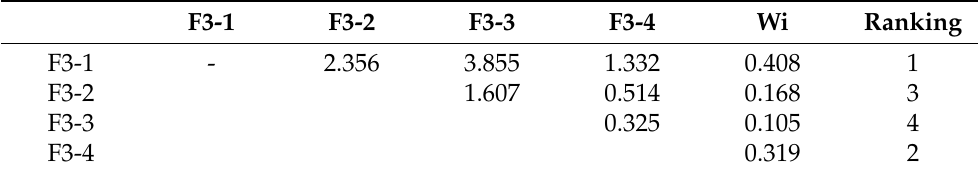
Table 10. Ranking of secondary factors in “green product marketing”.